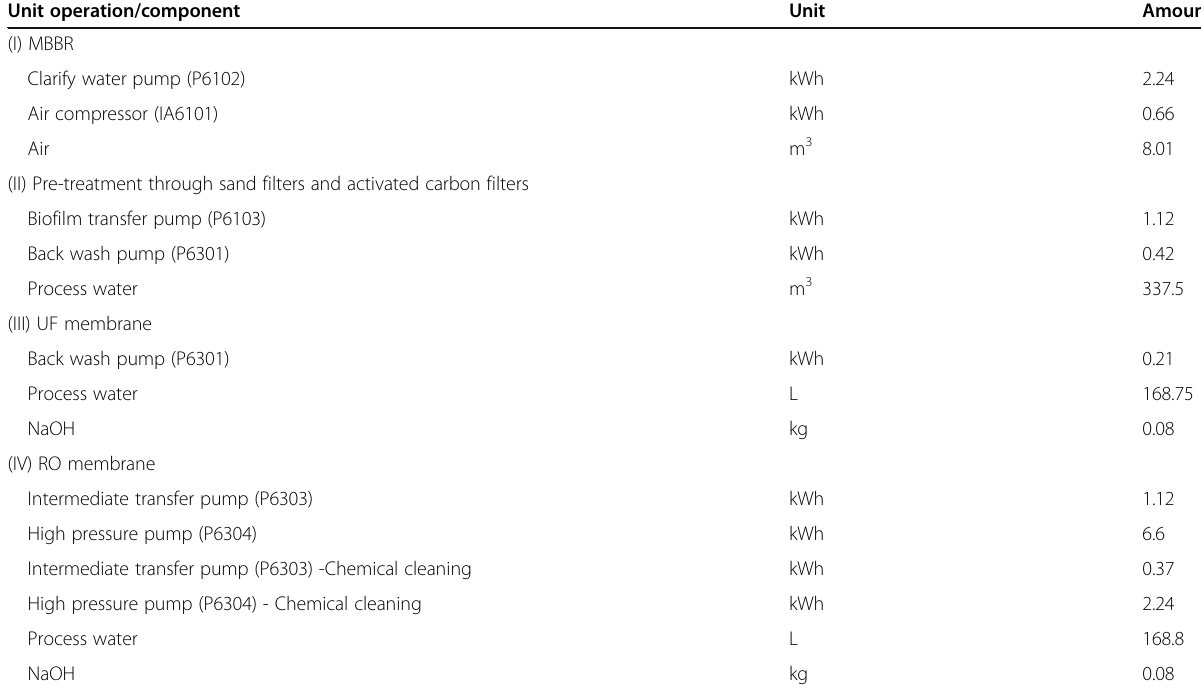
Table 1 Life cycle inventory of Combination I for integrated membrane-filtration system Unit operation/component